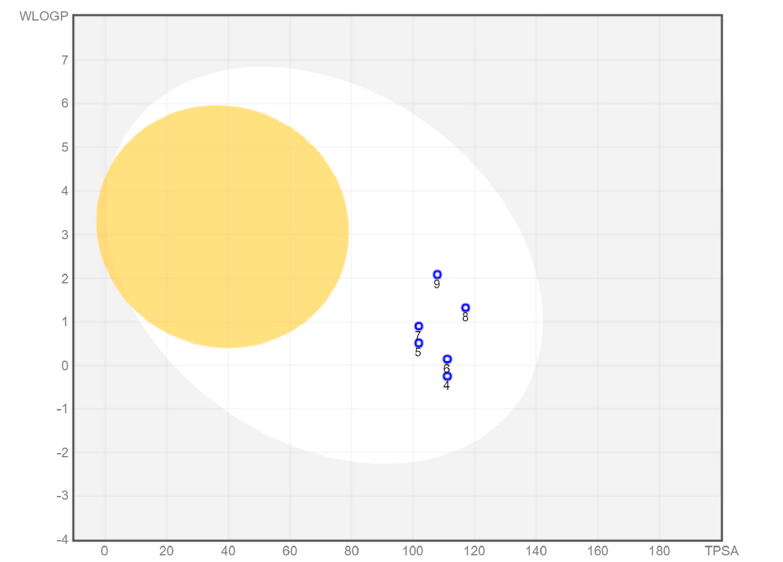
Figure 6. BOILED-Egg diagram for all compounds (lipophilicity (WLOGP) and polarity (tPSA), human intestinal absorption (white area), and blood–brain barrier permeation (yellow area).